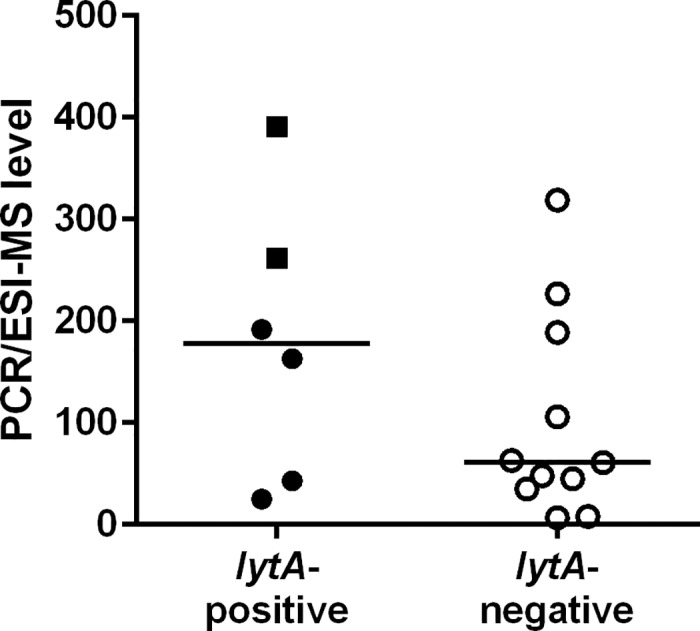
Detection of Streptococcus pneumoniae with PCR/ESI-MS.S. pneumoniae was detected in a total of 17 bronchoalveolar lavage samples. In 6 samples, the results were confirmed by PCR for lytA. Individual values with median are shown, the squares indicate culture-positive samples.